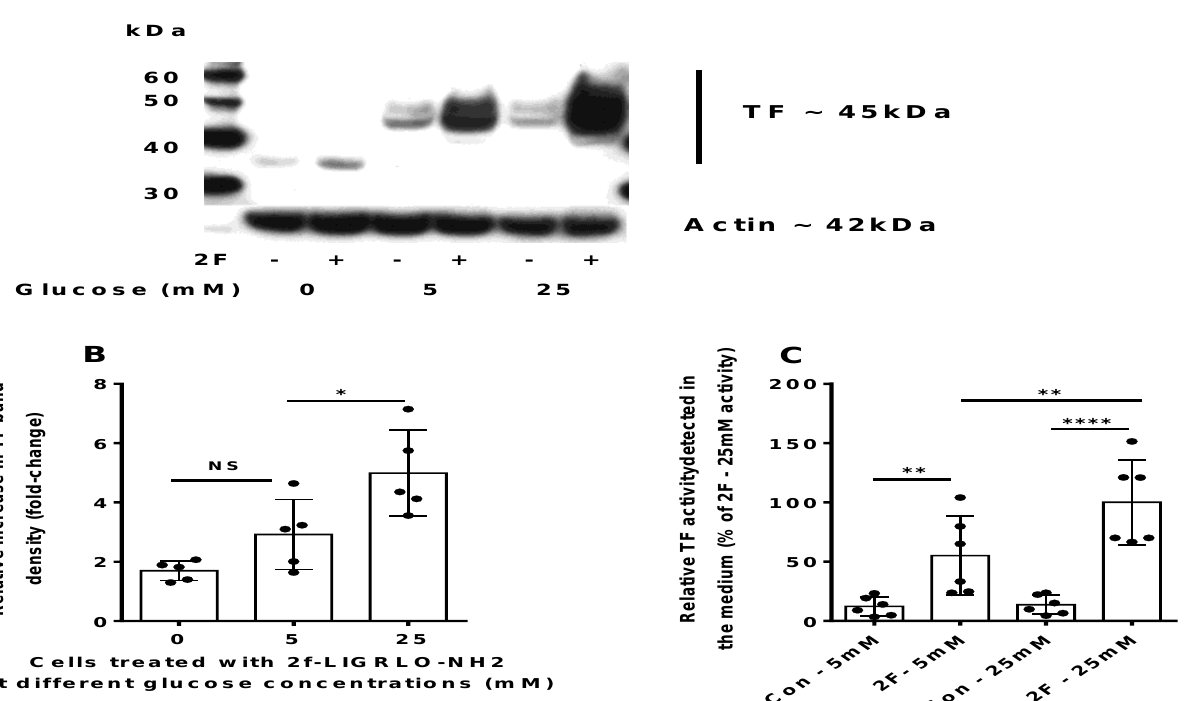
Figure 2. PAR2-induced TF synthesis and secretion by HTECs is enhanced by culture in a medium containing high glucose (25 mM) compared to low glucose (5 mM). ( A ) Representative Western blot showing the effect of glucose concentration on induction of tissue factor synthesis induced by 2F. ( B ) Semiquantitative analysis of the change in expression of TF-induced 2F when cells were cultured in 0, 5 or 25 mM glucose as measured by Western blot, (n = 5). ( C ) A chromogenic factor Xa activity assay was used to assess the TF activity present in the conditioned medium (secreted TF). (See Section 4 for details). T-tests were used to determine the significance of mean differences. Bars represent the mean ± SD *, **, and **** indicates significance of p < 0.05, p < 0.01 and p < 0.0001, respectively.